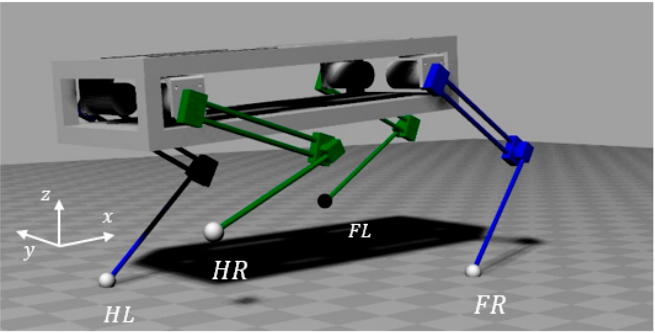
Figure 1. 3D view of the quadruped.